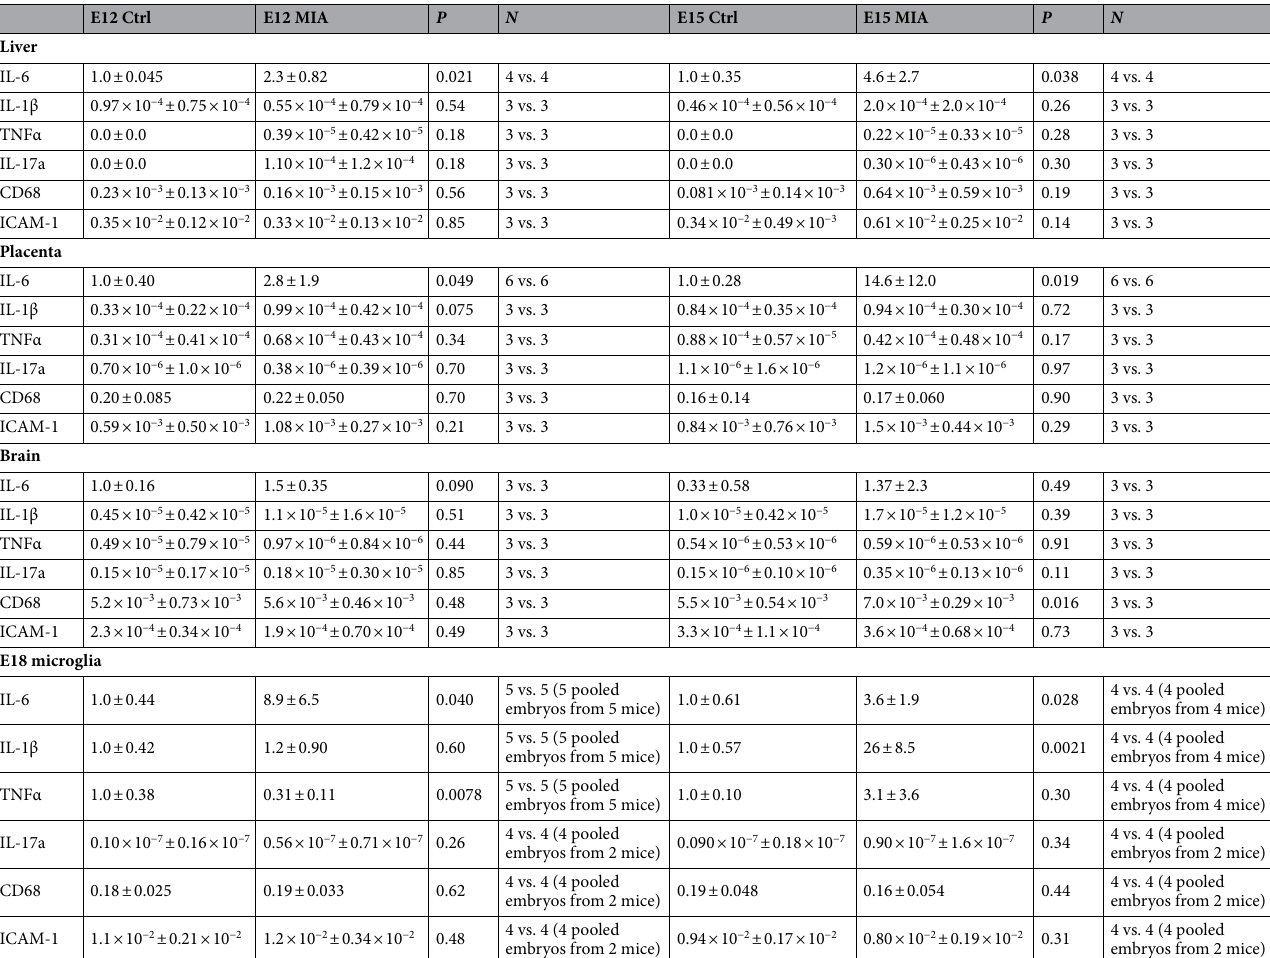
Table 1. Cytokines analysis of maternal organs and E18